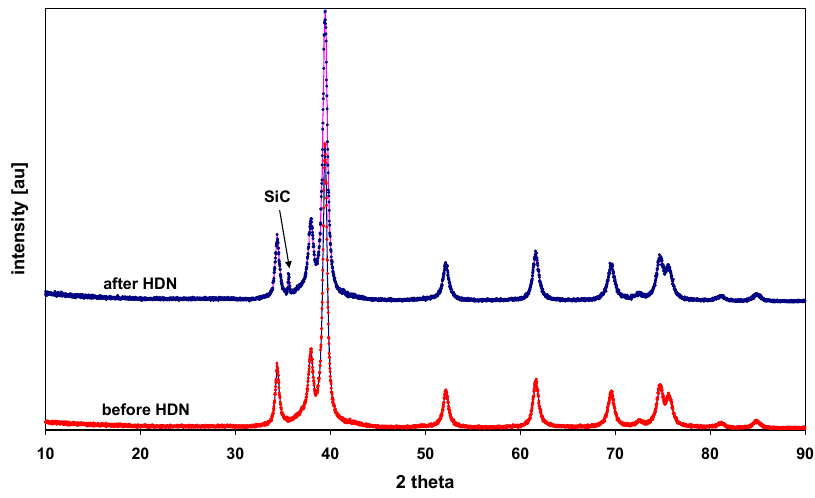
Figure 1. XRD patterns of molybdenum carbide (Mo 2 C) before and after hydrodenitrogenation (HDN) reaction of indole.